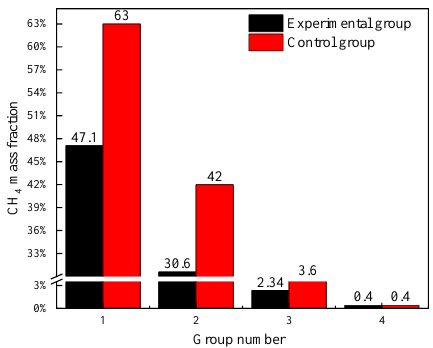
Figure 14. Comparison diagram of gas mass fraction in the inclined direction between the experi- mental and control groups.